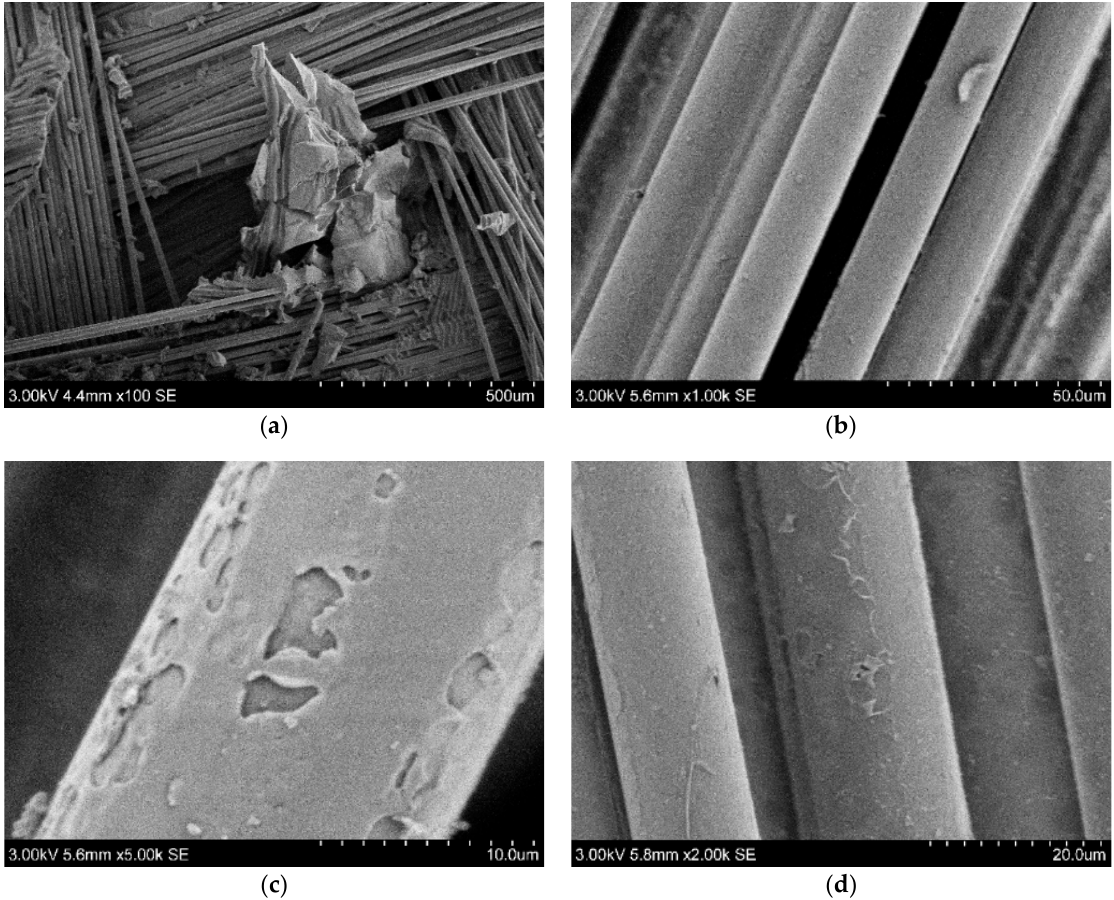
Figure 7. SEM microscopy of recovered fibers: ( a ) treatment with 2% catalyst for 3 h; ( b , c ) treatment with 2% for 6 h; ( d ) treatment with 5% for 2 h.